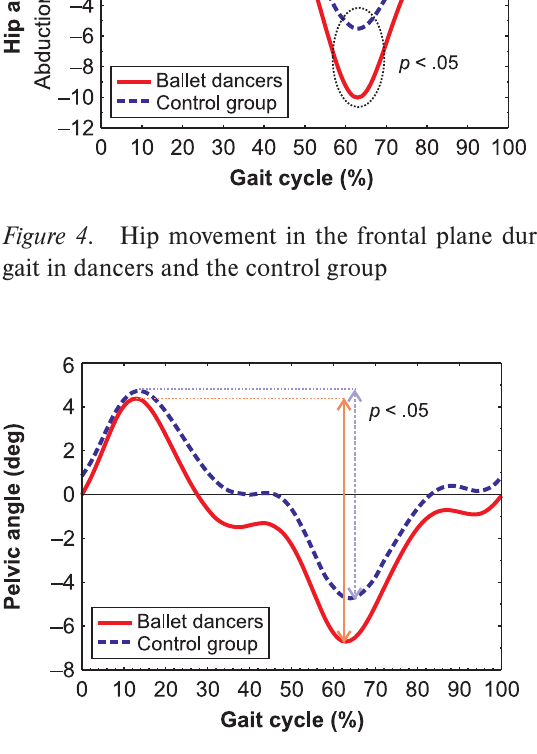
Figure 5. Pelvic movement in the frontal plane during gait in dancers and the control